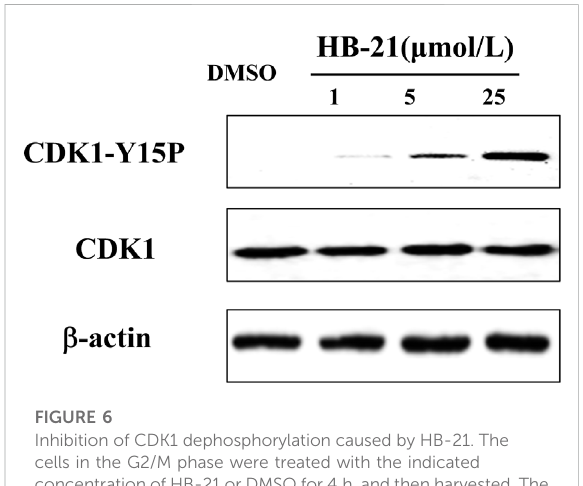
FIGURE 6 Inhibition of CDK1 dephosphorylation caused by HB-21. The cells in the G2/M phase were treated with the indicated concentration of HB-21 or DMSO for 4 h, and then harvested. The samples were processed for Western blot